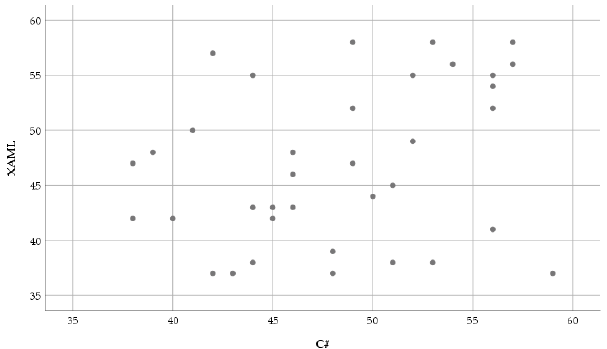
Figure 11. Sca tt er plot of the average pupil diameter (pixels) based on XAML and classic C#. The normality results of the average pupil diameter measured in the XAML code are signi fi cant (XAML: W (36) = 0.918, p = 0.011, C#: W (36) = 0.963, p = 0.269). Due to the results of the normality test, the Wilcoxon signed-rank test was used: ( T = 377.5, Z = 1.025, p = 0.305 (2-tailed), r = − 0.121). Regarding the obtained results, it can be stated that the average pupil diameter was not signi fi cantly smaller in the case of the XAML: Mdn = 46.5 than in